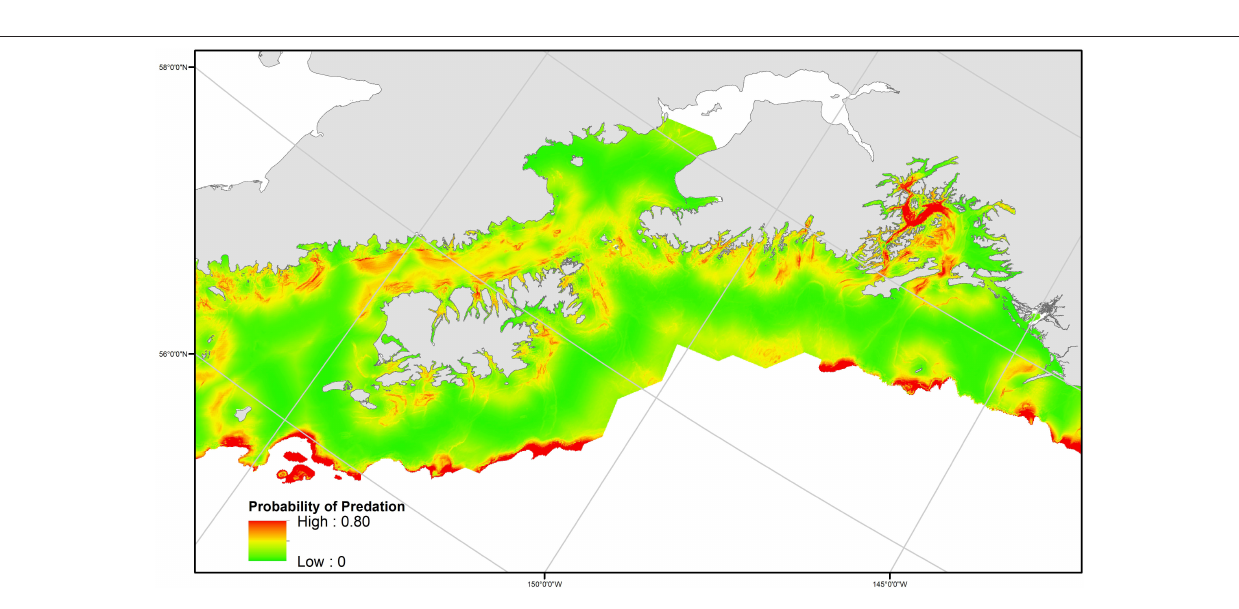
FIGURE 6 | Spatial distribution of predicted predation probability, as estimated from the best generalized additive model based on the relationship to distance to haulout, bathymetry (depth), and slope. The spatial extent is constrained by habitat (bathymetry and distances from haulouts) juvenile SSLs were associated with* in control data. *Note, association with bathymetry refers to the specific depth at a SSL movement location, not SSL usage of the vertical water